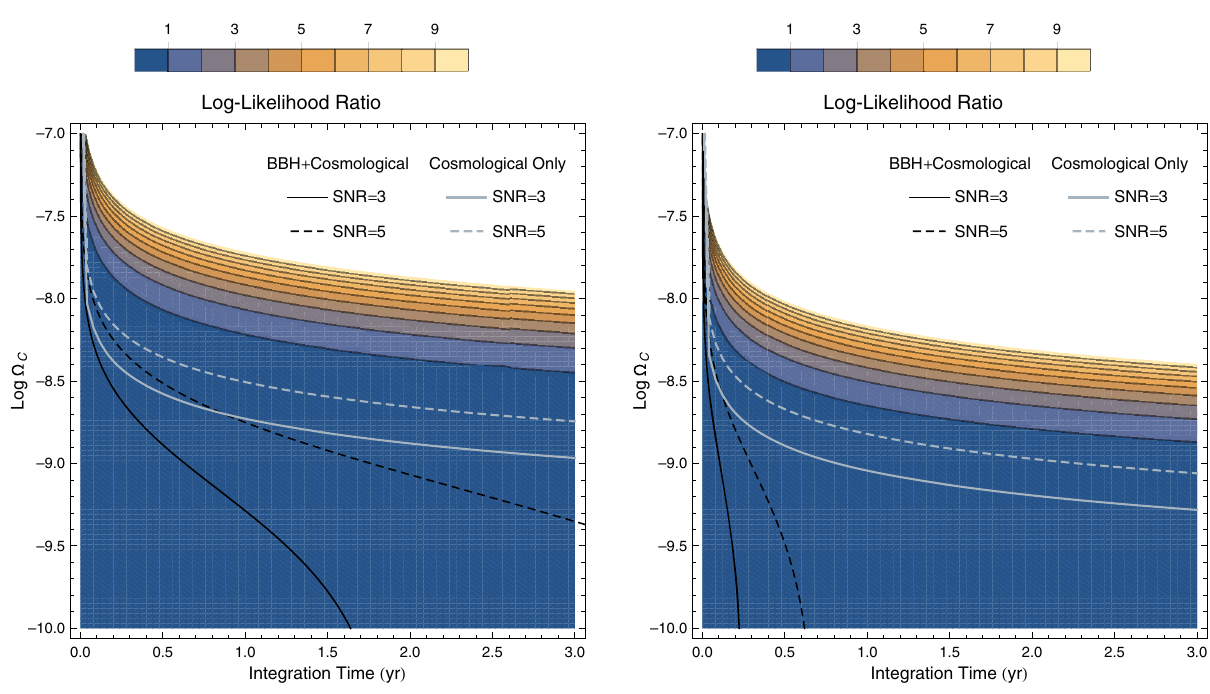
FIG. 6. Contours of the maximum likelihood ratio between the “ BBH+ ” and “ BBH-only ” models, as a function of the amplitude of the cosmological background Ω c and the total integration time. Results are shown for both the H1-L1 detector combination (left) and for two colocated detectors (right). Black curves indicate observation times required to detect the combined (astrophysical plus cosmological) background with a given optimal SNR. Gray curves indicate the amplitude of a flat cosmological background that alone would be detectable to a given SNR. Solid curves represent SNR ¼ 3 and dashed curves represent SNR ¼ 5